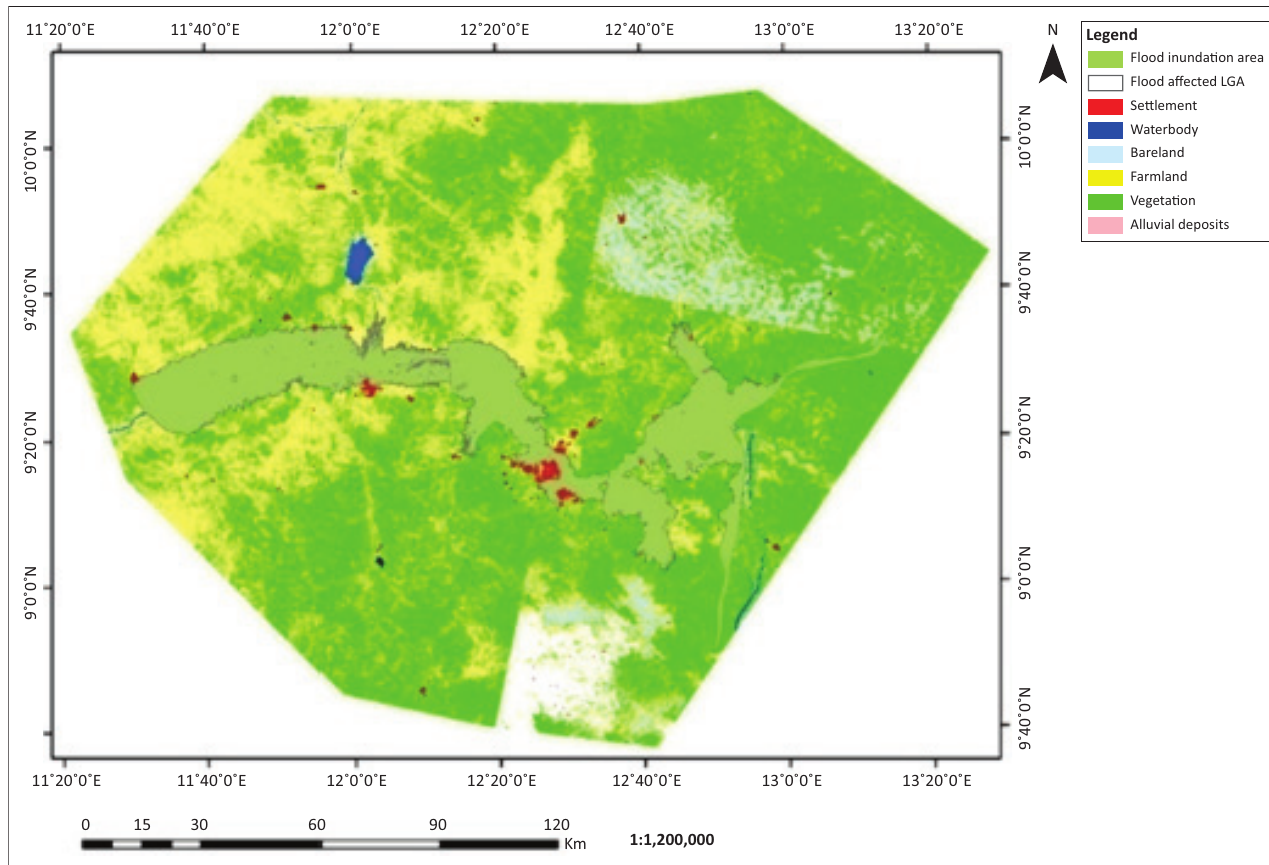
FIGURE 4: Flood inundation and land use and/or land cover map of Adamawa